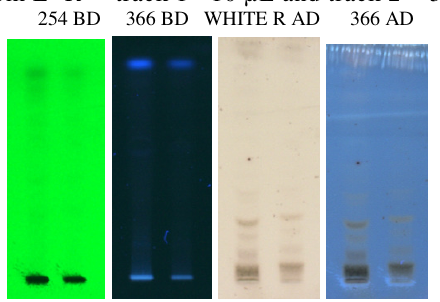
Figure 4. (Plate no 4) HPTLC of